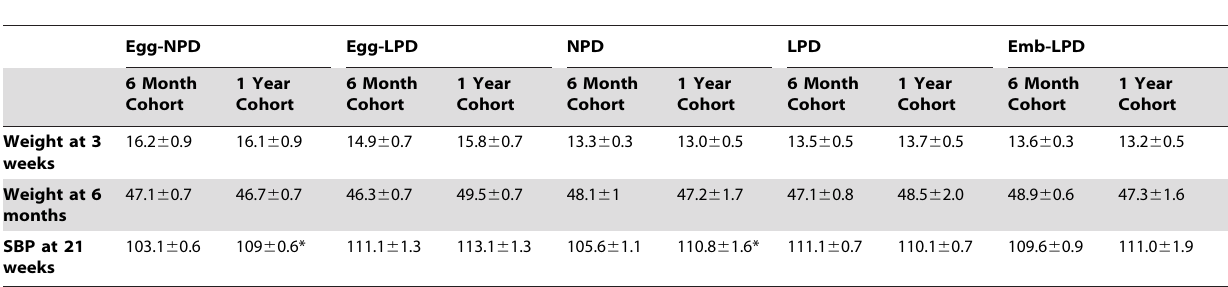
Table 3. Comparison of male offspring body weight and systolic blood pressure (SBP) measurements of mice analysed within the present study (1 Year Cohort) with the same treatment group from the larger cohort (6 Month Cohort) from which they were selected.